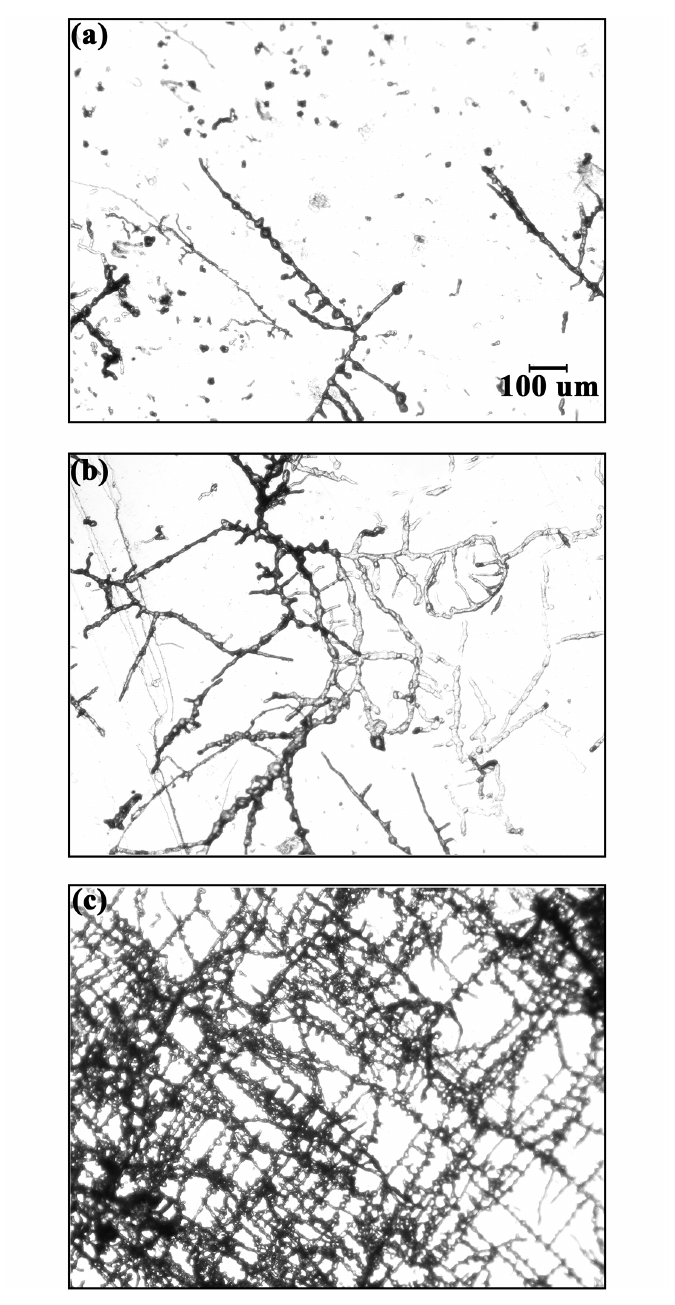
Fig 3. Top-down view of microborers within crystalline calcite at the Control (a), Mid-pCO 2 (b), and High-pCO 2 (c) sites. Scale bar in A is the same for all panels (100 μ m). Images are the same size and magnification as those used for surface area analysis.